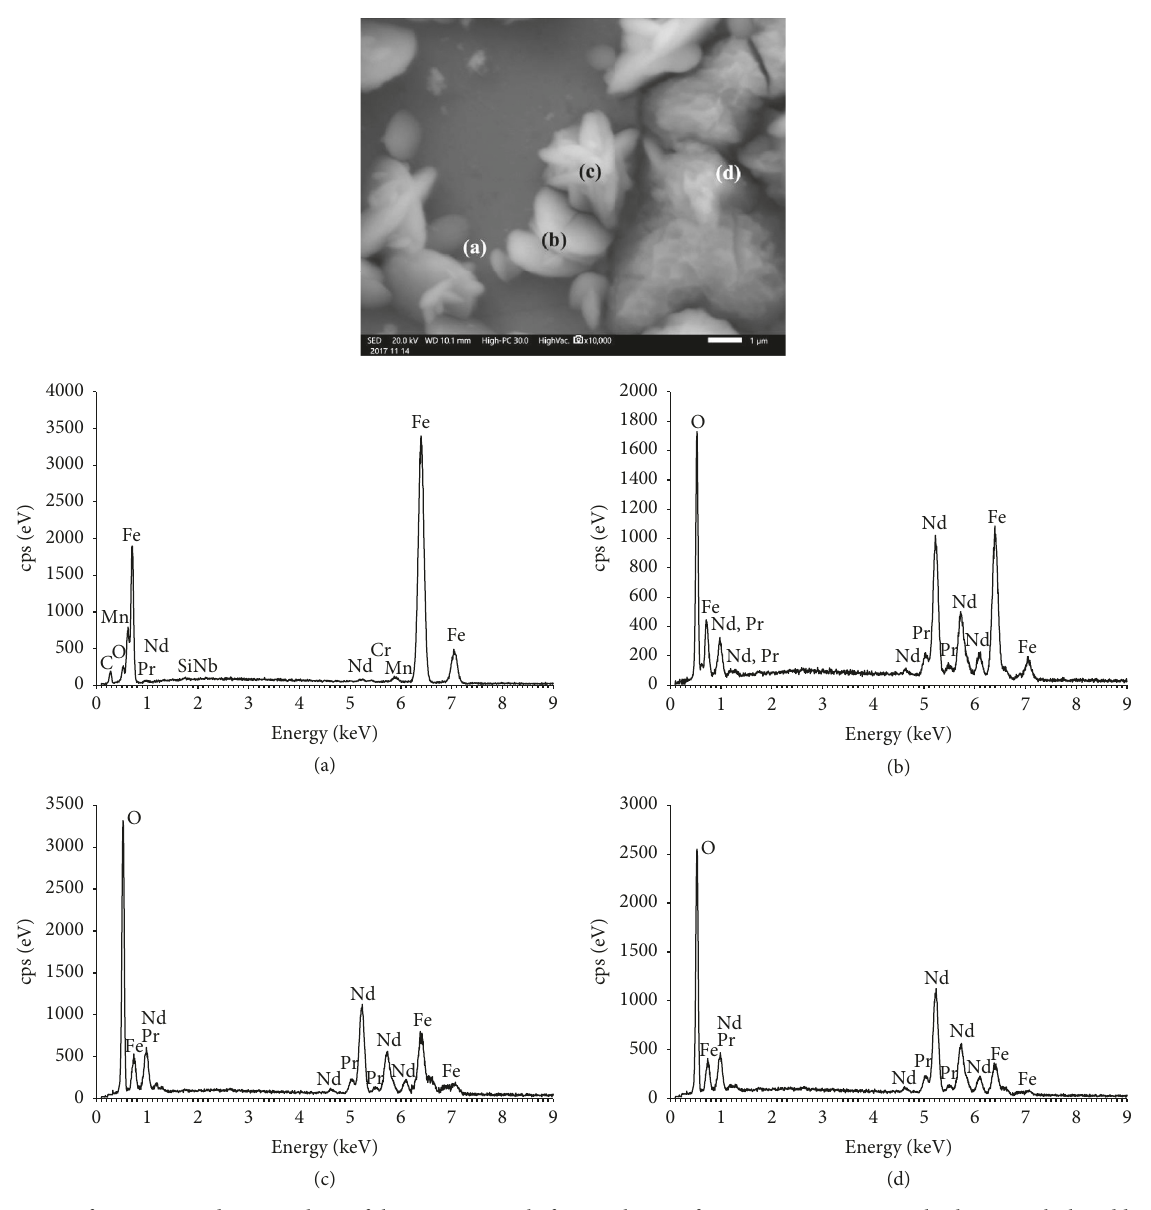
Figure 17: Surface aspect and EDS analysis of the API X70 steel after 100 hours of immersion in 3.5% NaCl solution with the addition of 0.001 M of inhibitor synthesized from permanent magnets. Table 3: Evolution of electrochemical parameters of the EIS spectra after 100 hours of immersion in 3.5% NaCl solution with 0.001M of inhibitor synthesized from permanent